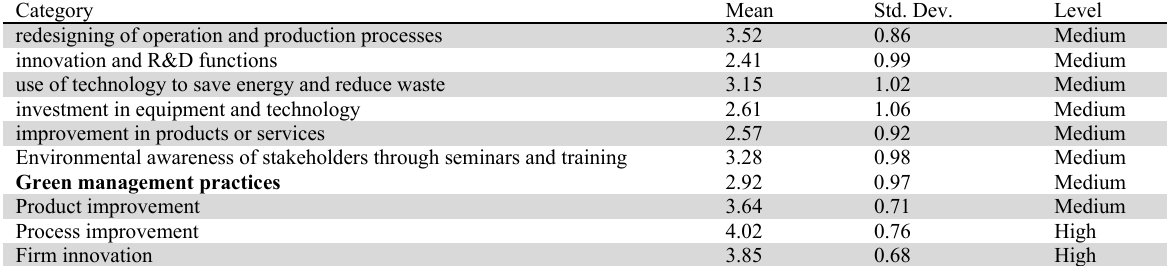
The mean and standard deviation for survey items Category Mean redesigning of operation and production processes